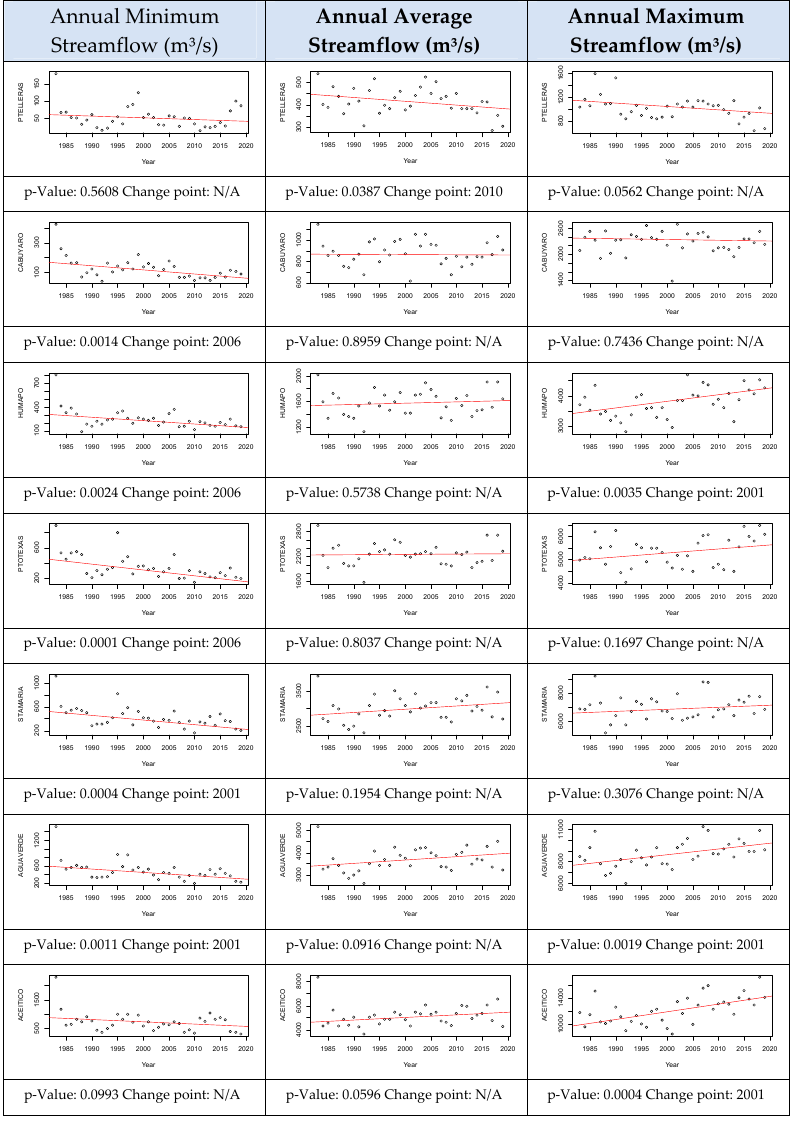
Figure 5. Pettitt’s test results and SS plot for minimum, average, and maximum annual streamflows in the Meta River.